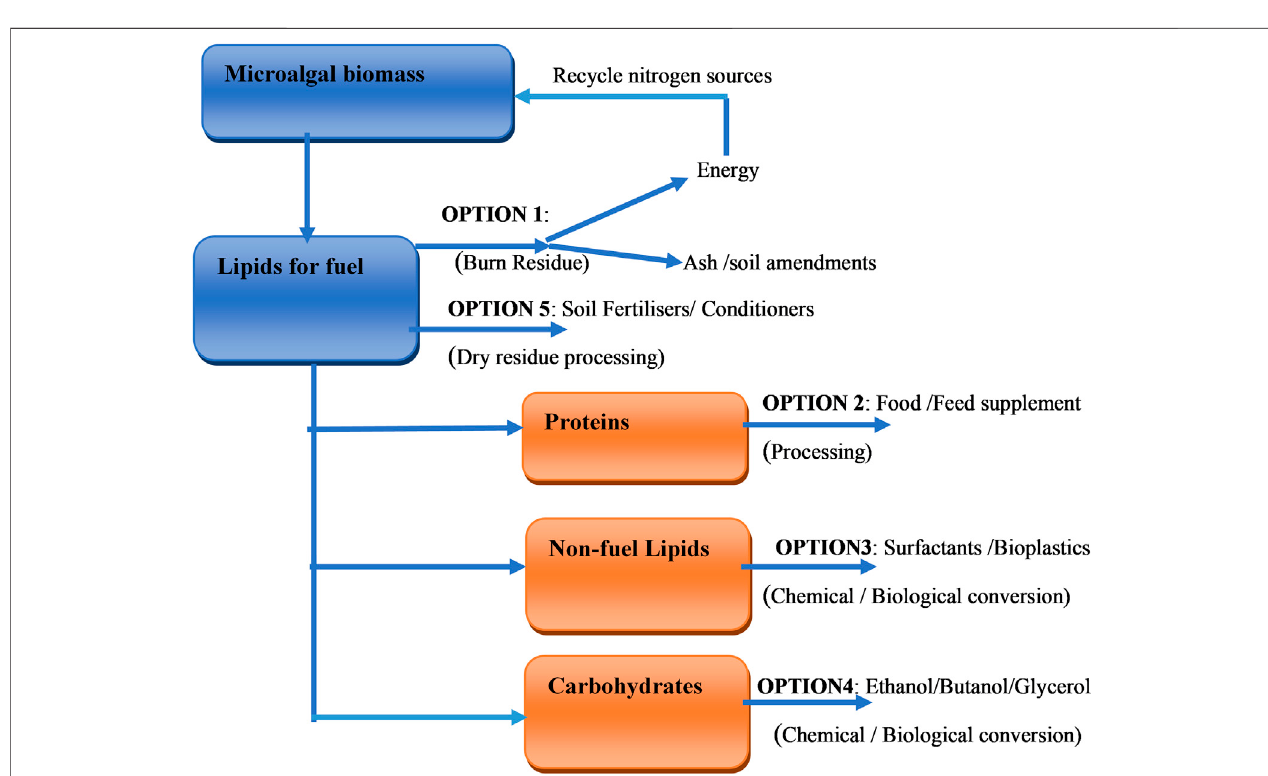
FIGURE 4 | Potential options for the recovery and use of co-products adapted from (U.S. DOE, 2010).